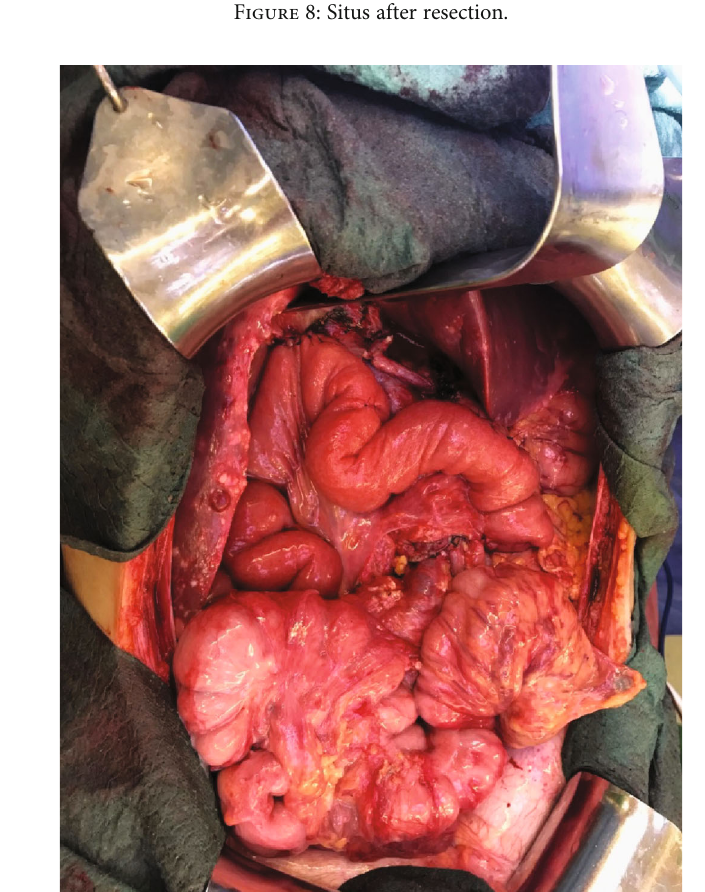
Figure 9: Situs after